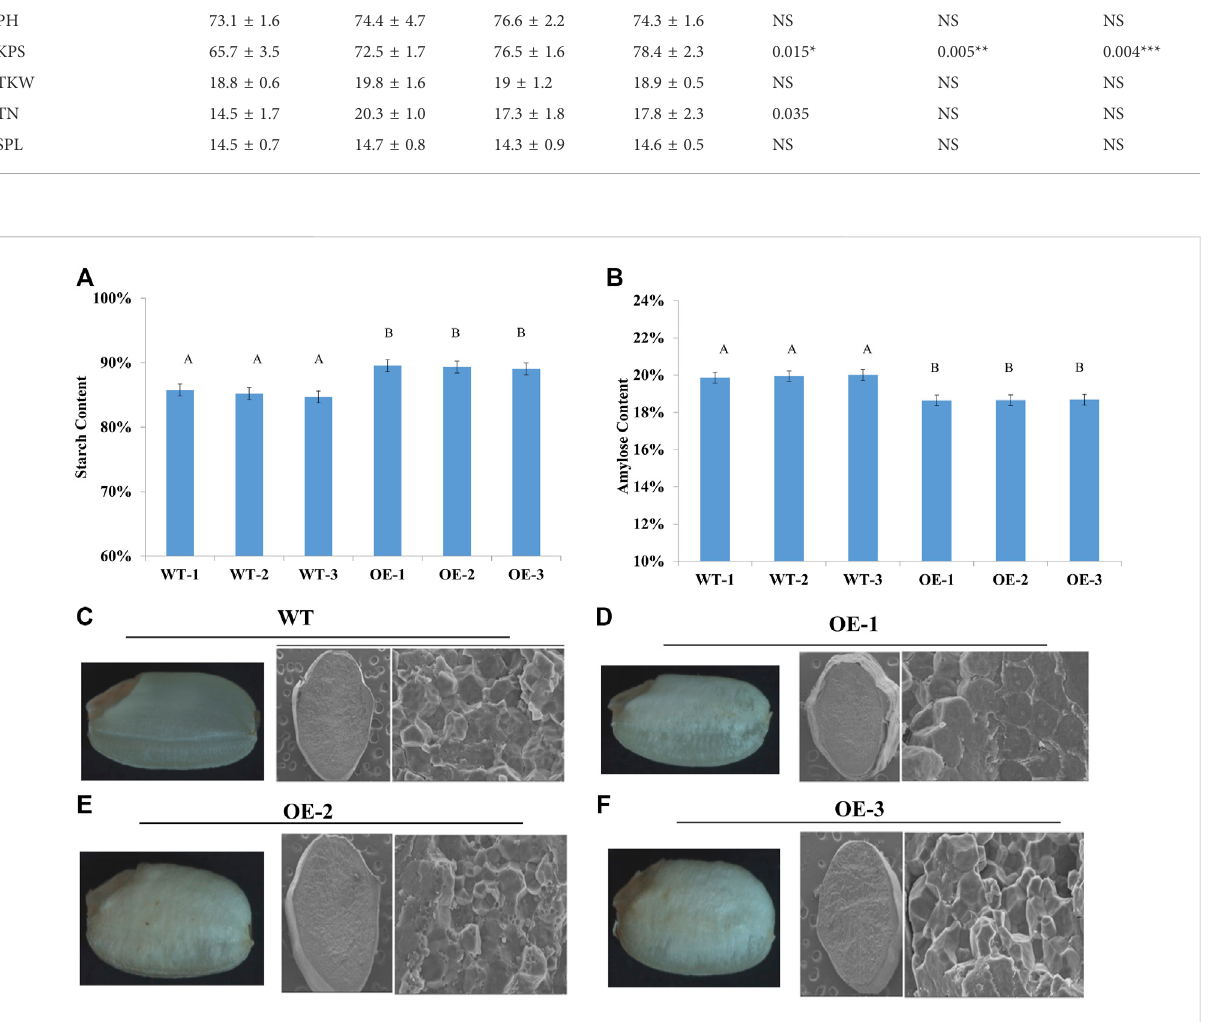
FIGURE 1 TaNAC020-B over-expressed rice heading colorand kerneldemonstratetheirpositive effectson starchsynthesis andaccumulation. (A) Starch content in wild type (WT) and over-expressing (OE) lines. (B) Amylose content in WT and OE lines. (C – F) Starch density and amylose content in WT and OE under scanning electron